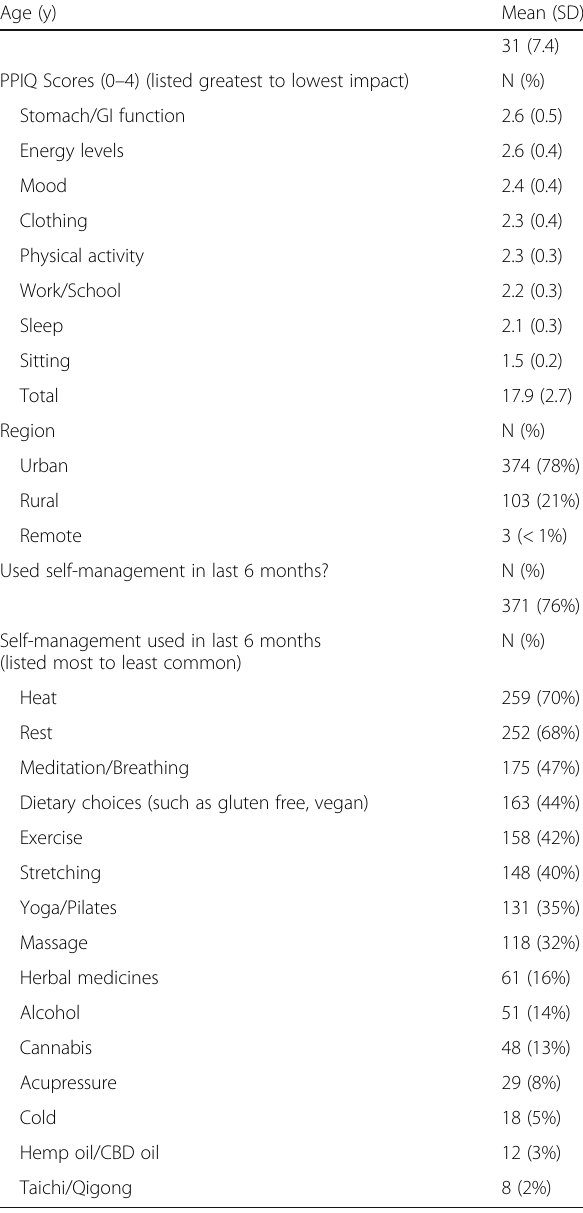
Table 1 Characteristics of survey respondents ( N =